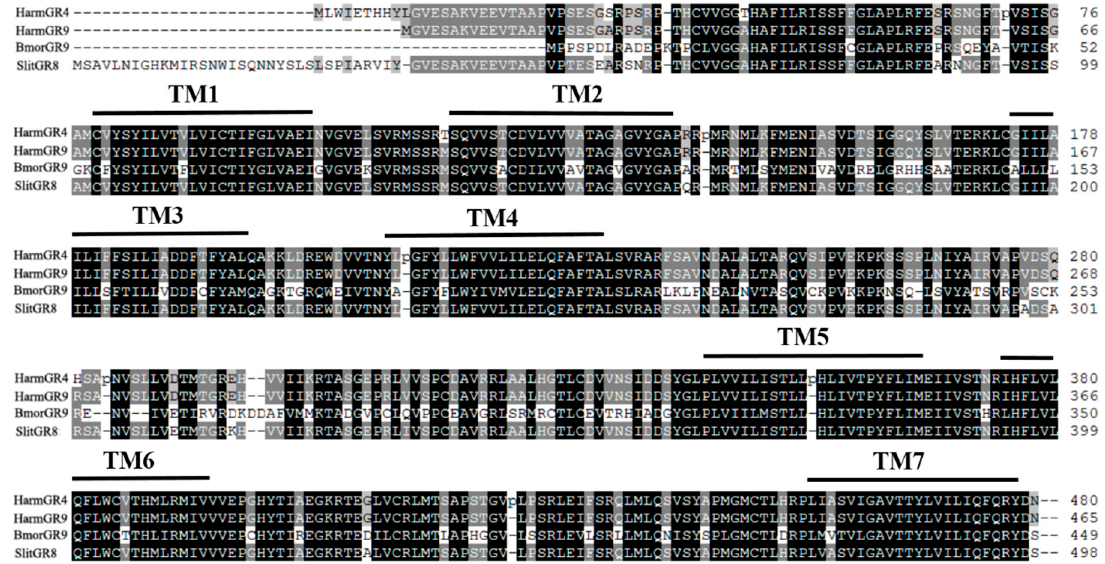
Figure 1. Alignment of the amino acid sequences of four lepidopteran fructose GR genes, showing positions of seven predicted transmembrane domains ( TM1 – TM7 ). Identical amino acids are marked with black shading. Insect species and GenBank IDs of the GR genes are same as in Table 1.